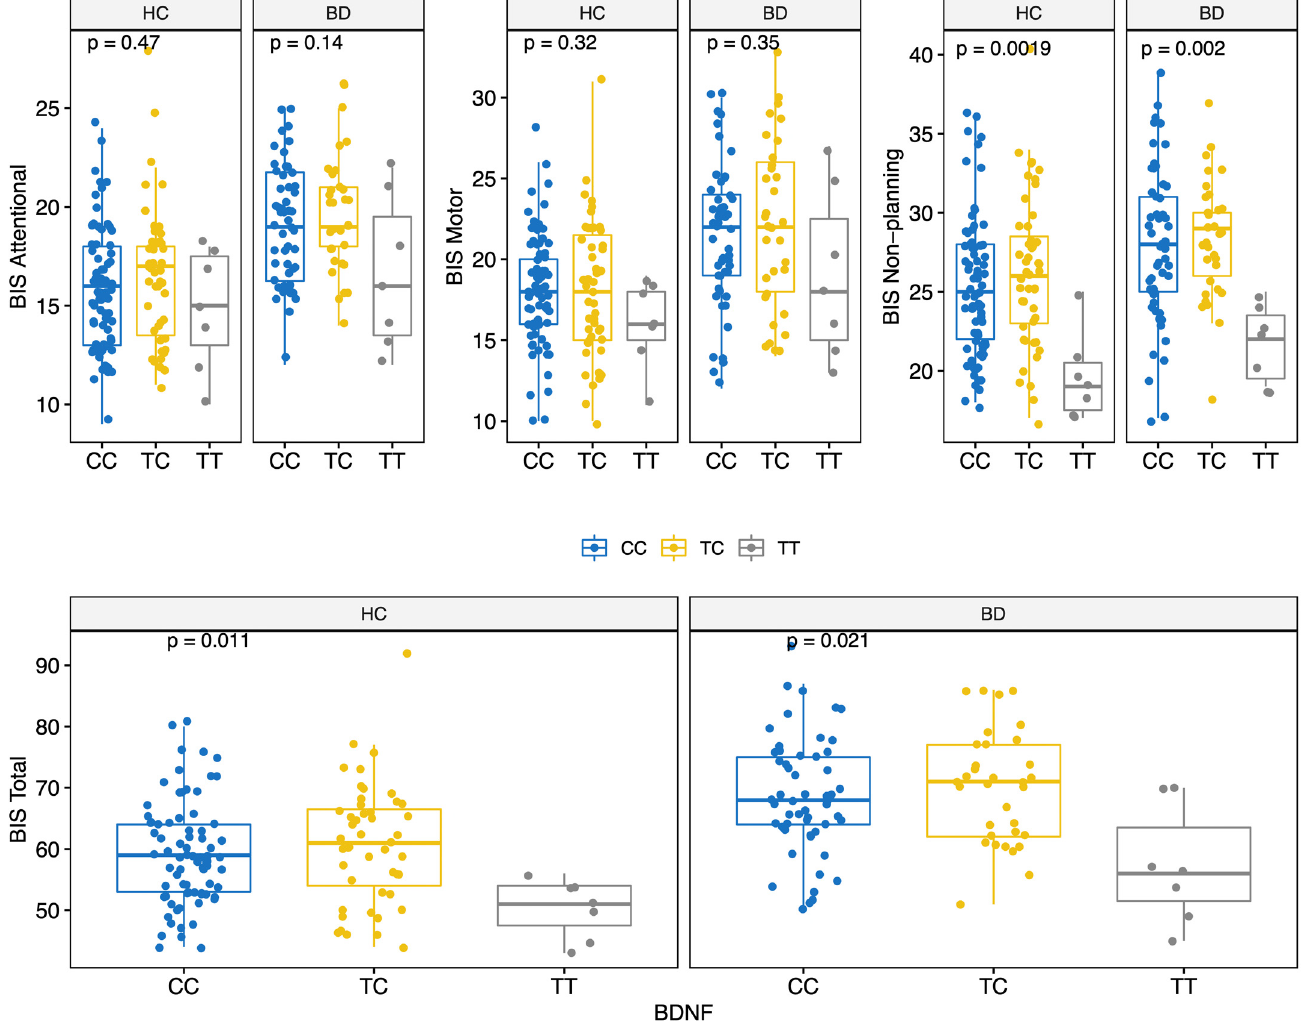
Figure 3. BIS score (Attentional, Motor, Non-Planning and Total) by BDNF polymorphisms for HC and BD.